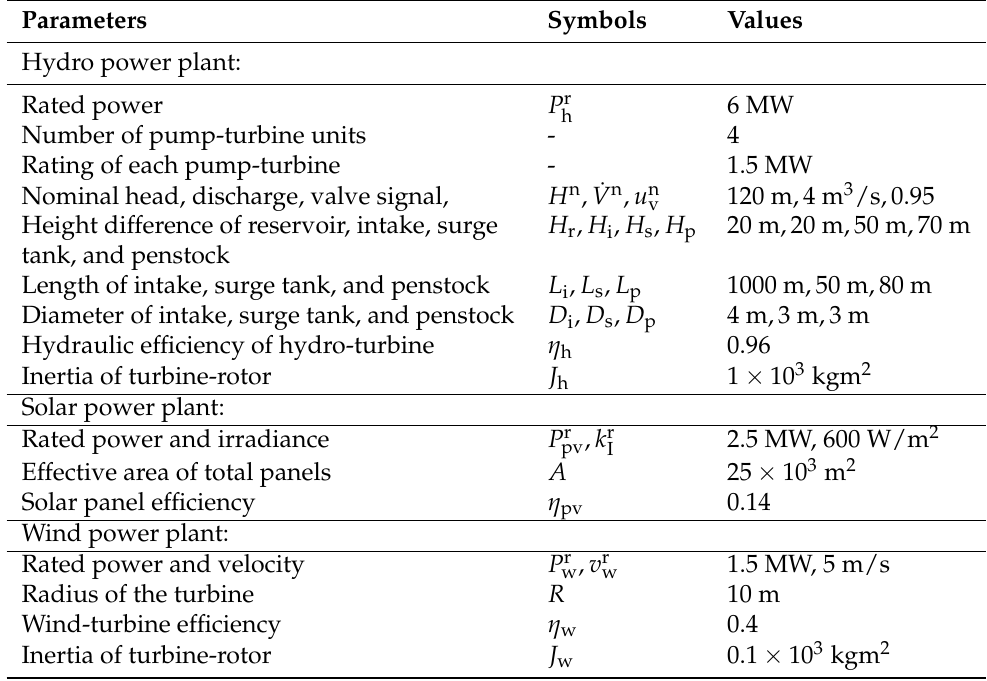
Table 1. Specification of case study power plants.